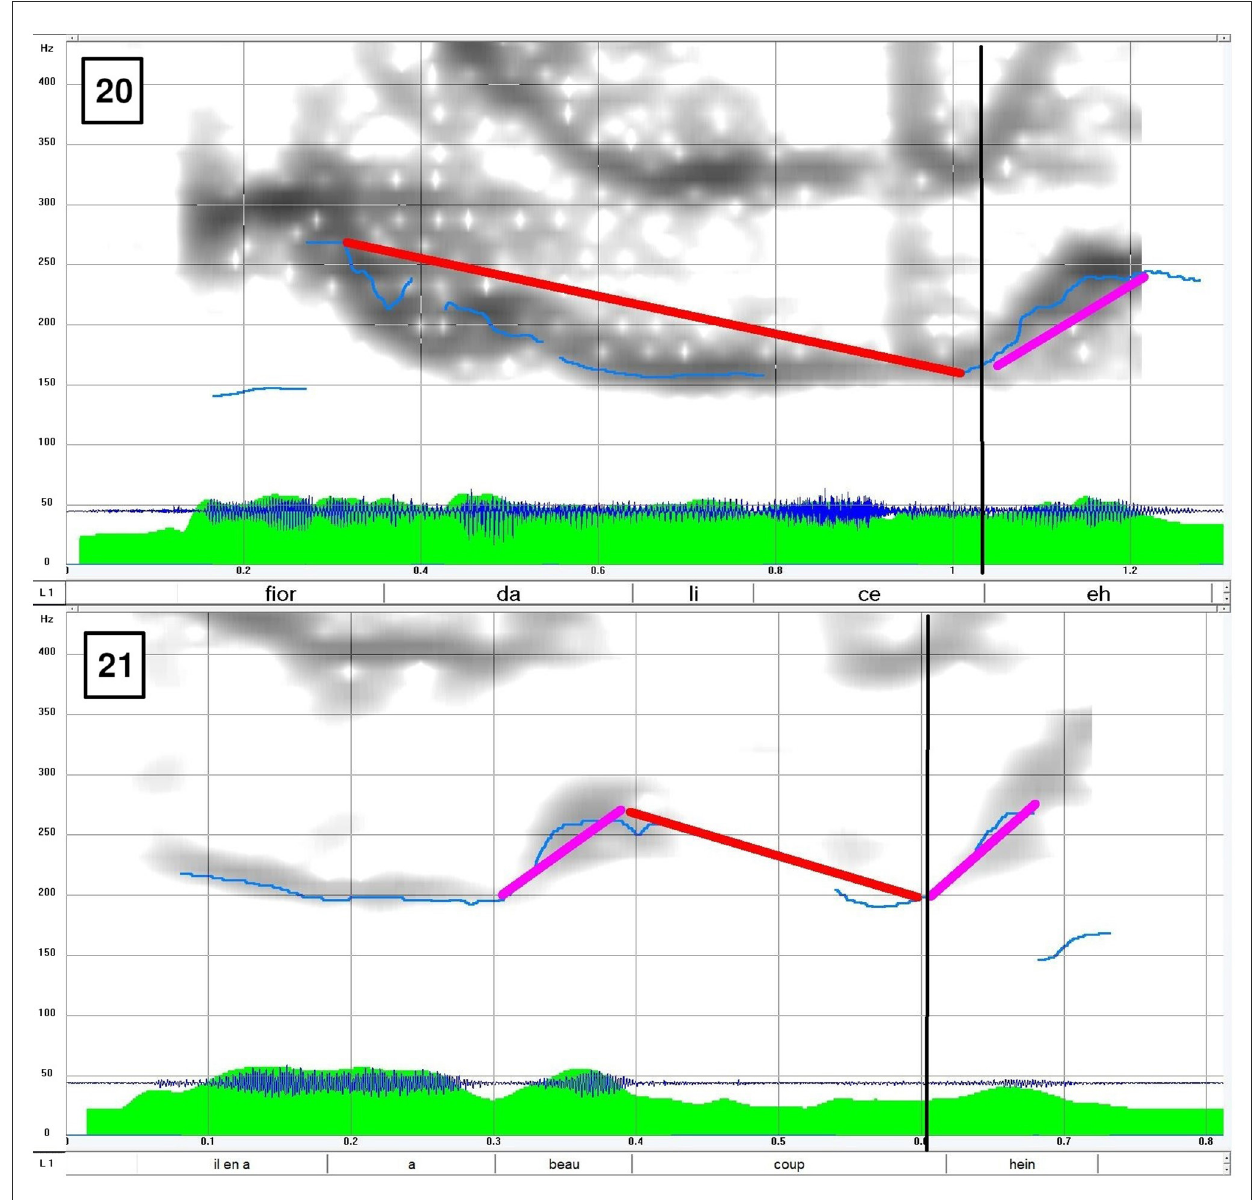
FIGURE12 Prototypic contours of Tag questions in Italian and French (20; 21) (Supplementary Audio 9.wav).